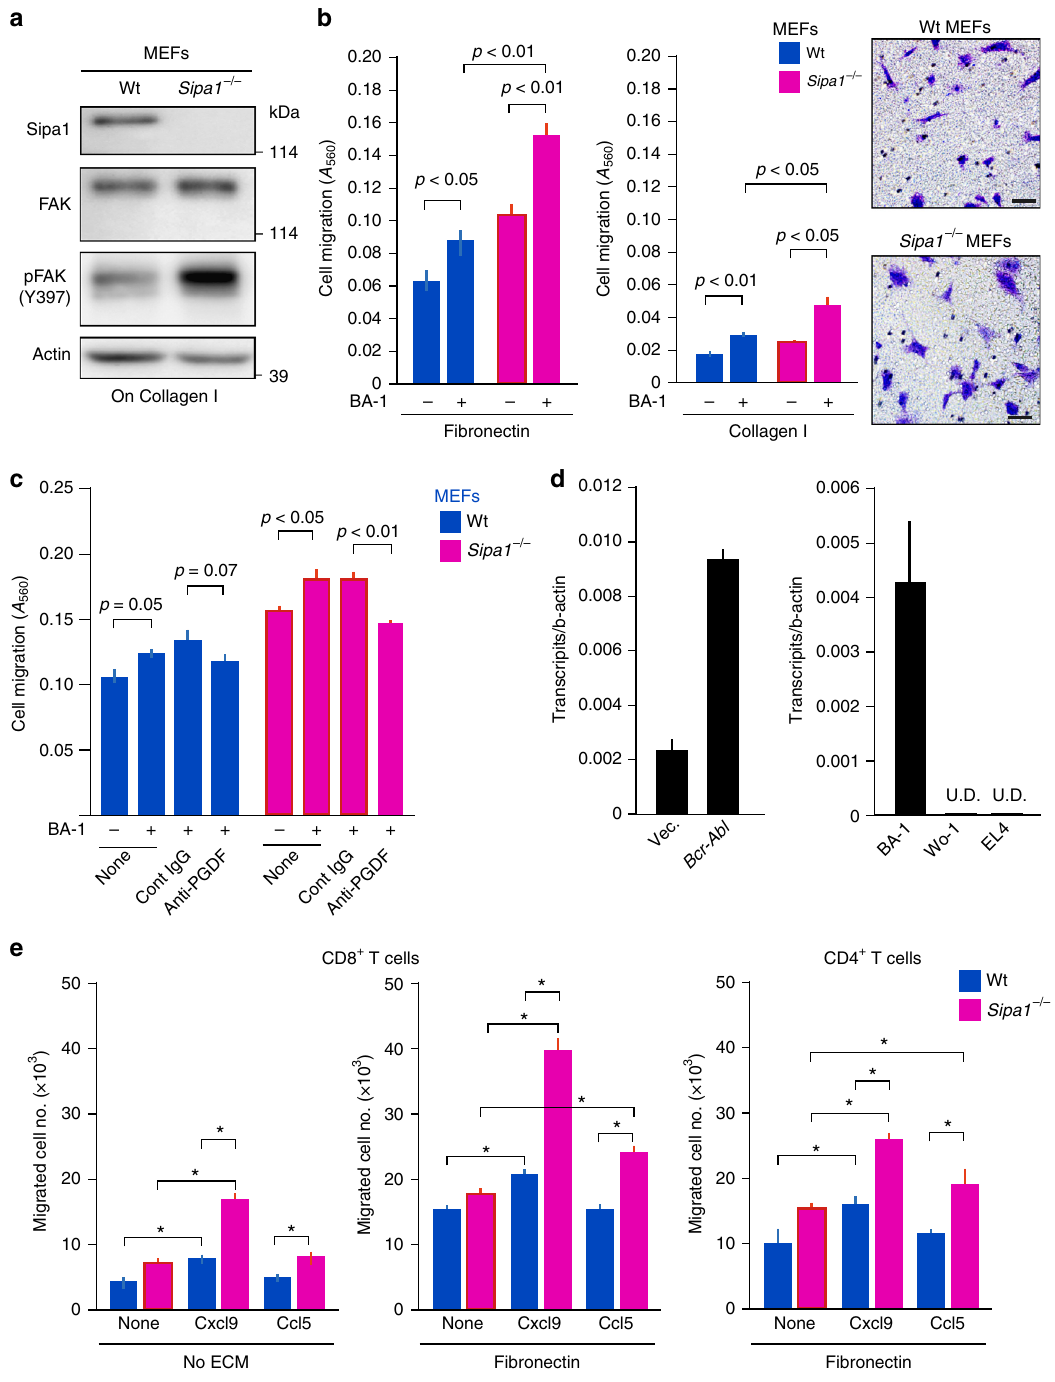
Fig. 8 Sipa1 − / − MEFs show enhanced migration directed to Bcr-Abl + CML cells and Sipa1 − / − T cells augmented chemotaxis in response to chemokines. a Wt and Sipa1 − / − MEFs cultured on collagen I were lysed and immunoblotted with indicated antibodies. b Directed migration of Wt and Sipa1 − / − MEFs to BA-1 CML cells were assessed using the Boyden chamber assay in the presence of fi bronectin or collagen I. The means and SEs of quadruplicate culture are shown, and p values were determined with two-tailed unpaired Student ’ s t -test. The experiments were repeated three times with similar results. Pictures of crystal violet-stained migrated cells are also indicated. Scale bars, 50 μ m. c In the Boyden chambers, anti-PDGFa antibody or isotype-matched control IgG was added to the lower wells at 20 μ g/mL with BA-1 cells. The means and SEs of quadruplicate culture are shown, and p values were determined with two- tailed unpaired Student ’ s t -test. d Primary Lin − BM cells were transduced with p210Bcr-Abl or control vector. Three days later, GFP + cells were sorted, and Pdgfa expression was assessed with quantitative PCR (left). Expression of Pdgfa in BA-1, Wo-1, and EL4 cell lines was also examined (right). U.D., undetectable. e Chemotactic activity of sorted Wt and Sipa1 − / − CD8 + T cells and CD4 + T cells that had been activated on the coated anti-CD3 antibody for 24 h were assessed in response to Cxcl9 and Ccl5 (100 ng/mL) using the Boyden chamber assay in the presence or absence of fi bronectin. The means and SEs of triplicate determination are shown. The experiments were repeated at least two times with similar results. * p < 0.01 (two-tailed unpaired Student ’ s t